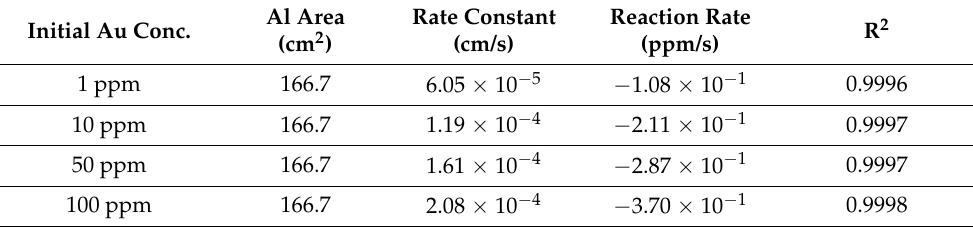
Table 1. Summary of rate constant for the cementation of Au onto the Al as a function of initial Au concentration (base conditions: 10 mL solution containing 1 M of Na 2 S 2 O 3 , 0.5 M of NH 3 , 0.25 M